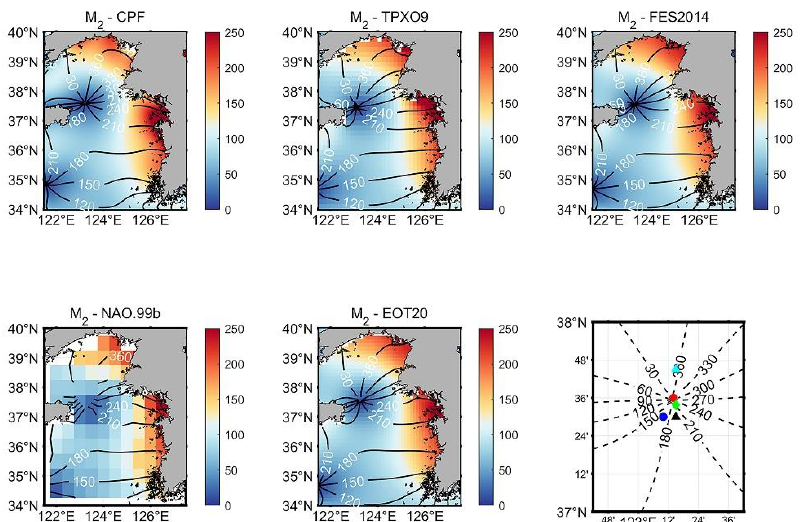
Figure 5. The cotidal charts of the M 2 constituent from the CPF method and the TPXO9, FES2014, NAO.99b and EOT20 models, and the amphidromic points of the CPF method and the four models (unit: cm). Red dots: amphidromic points of the CPF method; Bule dots: amphidromic points of the TPXO9 model; Green rhombus: amphidromic points of the FES2014 model; Cyan triangle: amphidromic points of the NAO.99b model; Black triangle: amphidromic points of the EOT20 model.